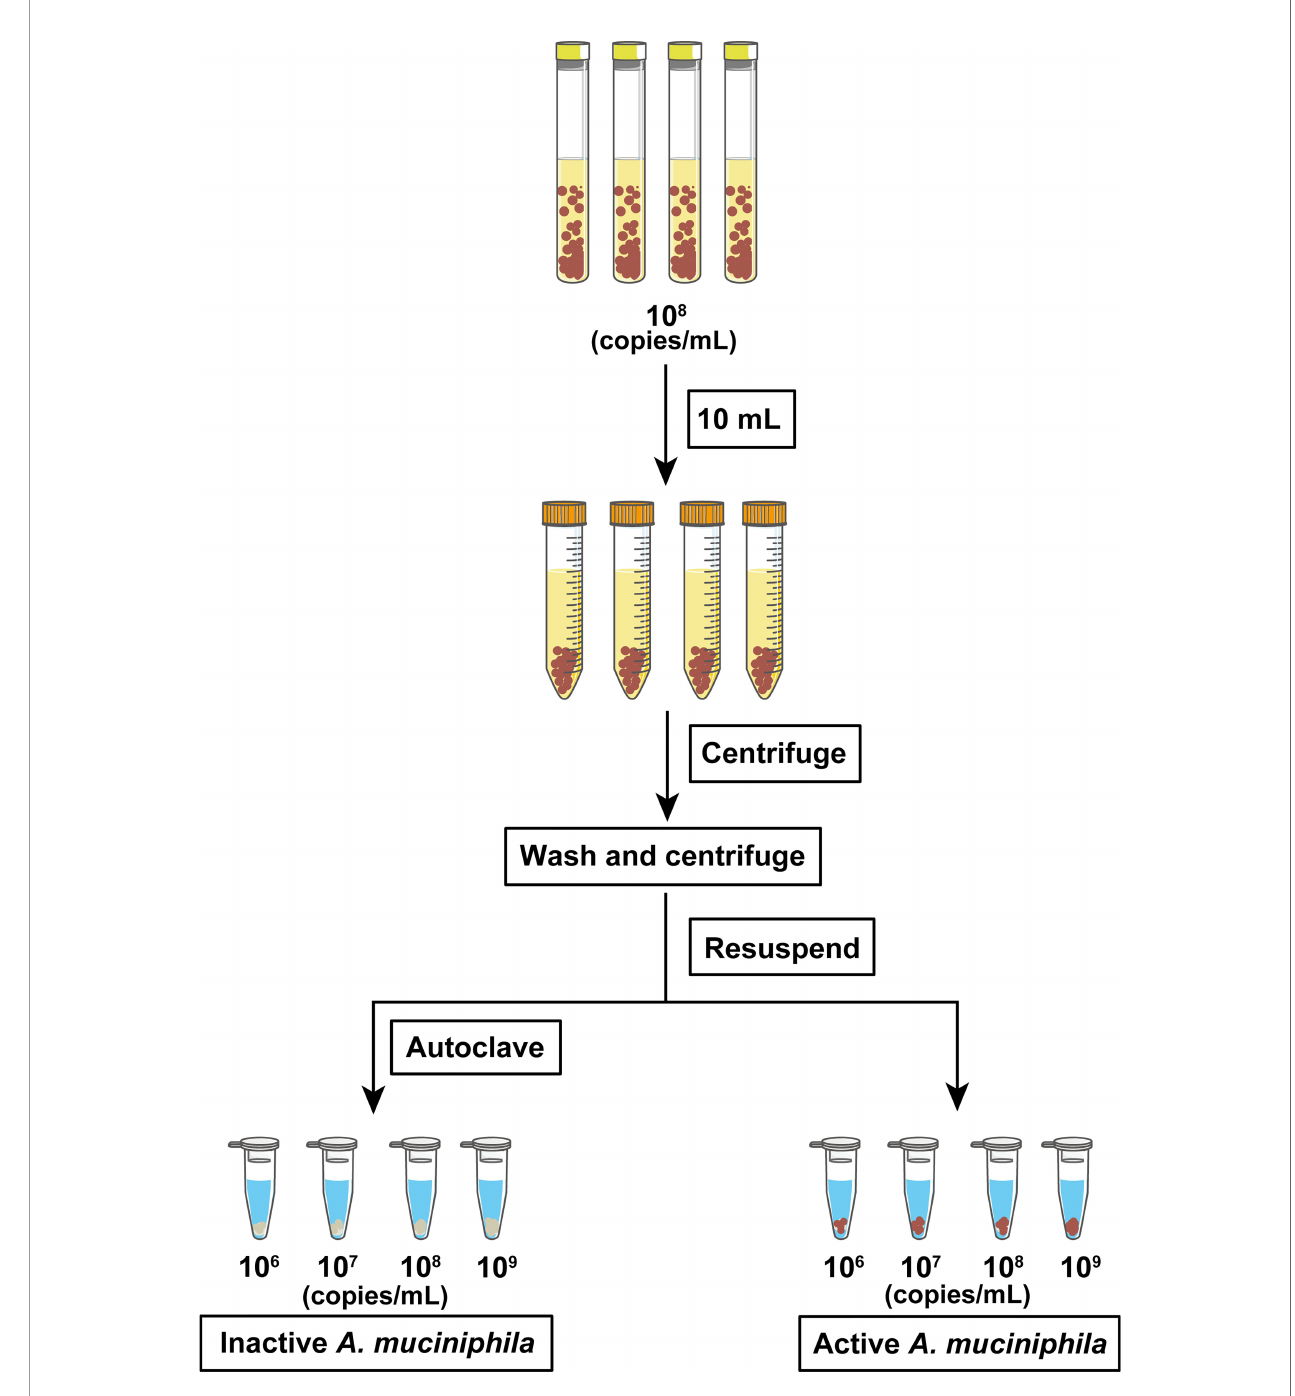
FIGURE 1 | Flow chart of the preparation of active and autoclaved inactive A. muciniphila